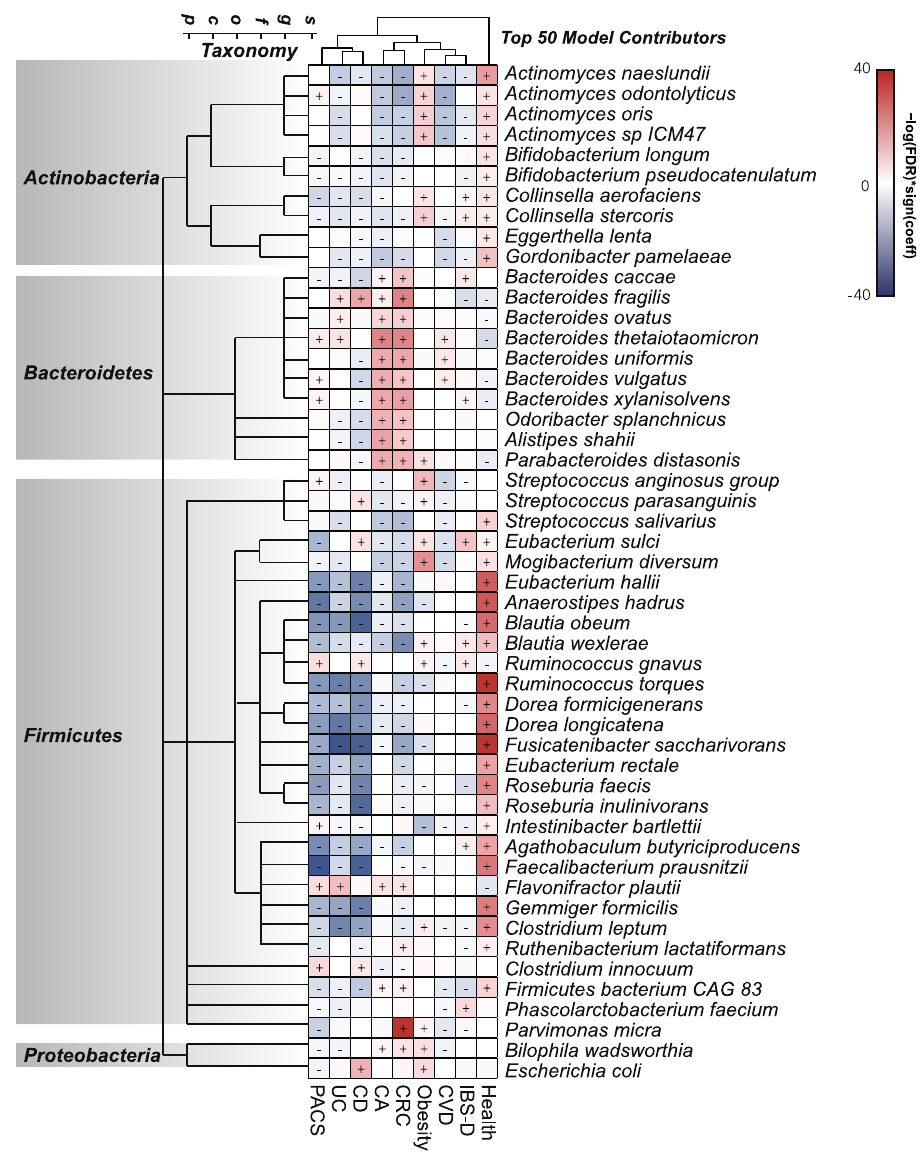
Fig. 2 | Microbial species associated with health status or different disease phenotypes. Thetop50microbialspeciescontributingtotherandomforestmulti- class classi fi er were clustered by taxonomy, and different phenotypes were clus- tered using hierarchical clustering. Associations were coloured by direction of effect (red, positive; blue, negative; p <0.05), with associations signi fi cant at FDR<0.05 marked with a plus (positive correlations) or minus (negative